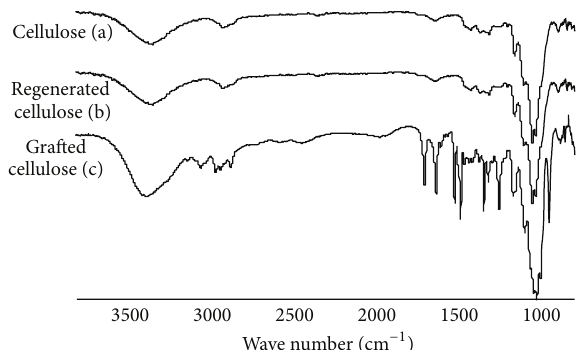
Figure 1: IR spectra of kraft cellulose (a), regenerated cellulose, (b) and grafted cellulose